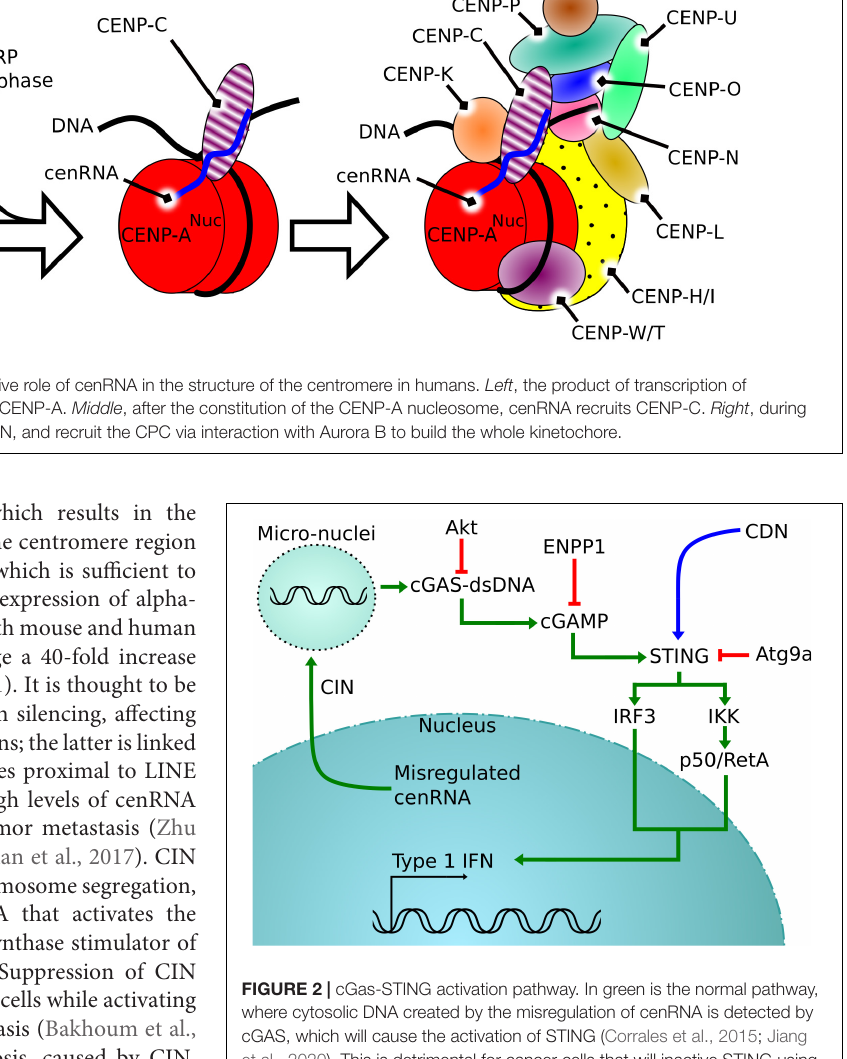
FIGURE 2 | cGas-STING activation pathway. In green is the normal pathway, where cytosolic DNA created by the misregulation of cenRNA is detected by cGAS, which will cause the activation of STING (Corrales et al., 2015; Jiang et al., 2020). This is detrimental for cancer cells that will inactive STING using different strategies, in red (Saitoh et al., 2009; Xiong et al., 2018). One possible rescue is to inject synthetic CDN to force the activation of STING, shown in blue (Corrales et al.,